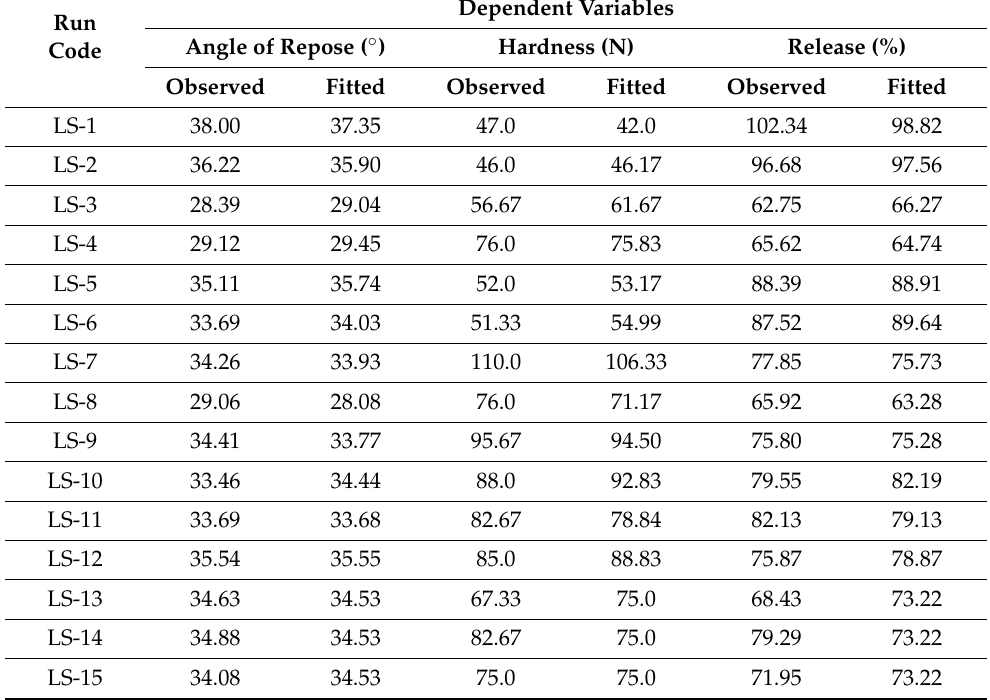
Table 5. Observed and fitted values for the selected responses as per Box–Behnken design.